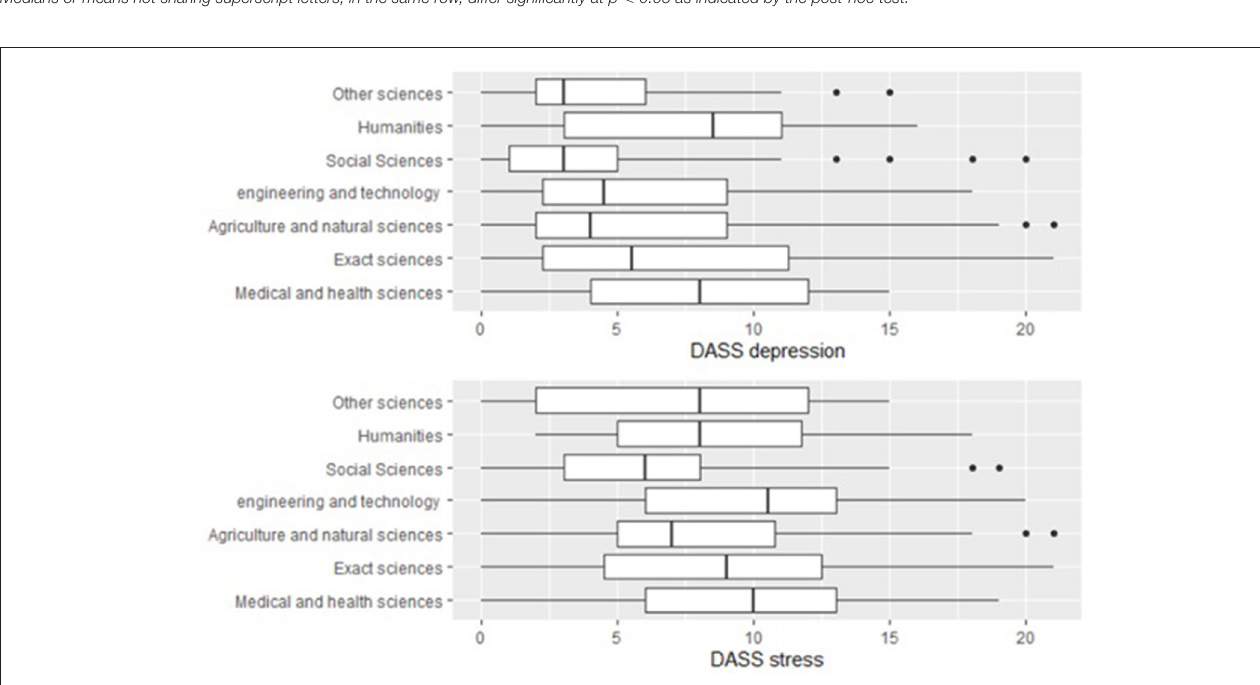
tend to be overrepresented in this profession as well as among such frontline service workers